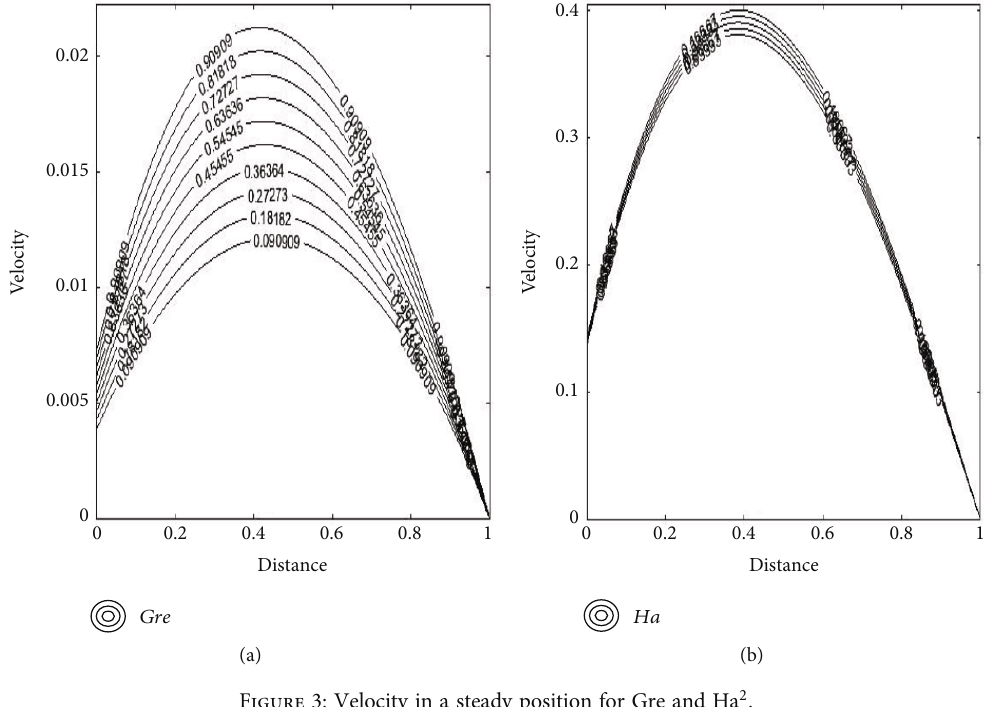
Figure 3: Velocity in a steady position for Gre and Ha 2